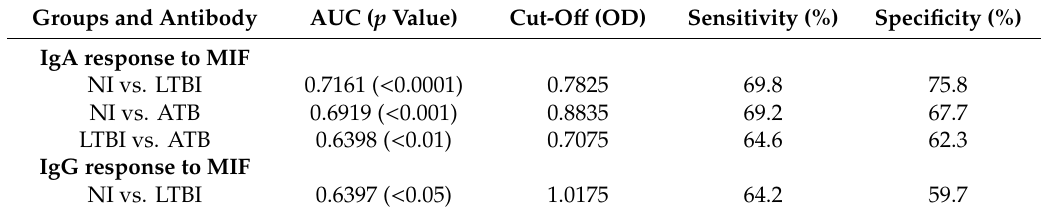
Table 1. Efficiencies of immunoglobulin (Ig)A and IgG against MIF as diagnostic markers for tuberculosis.